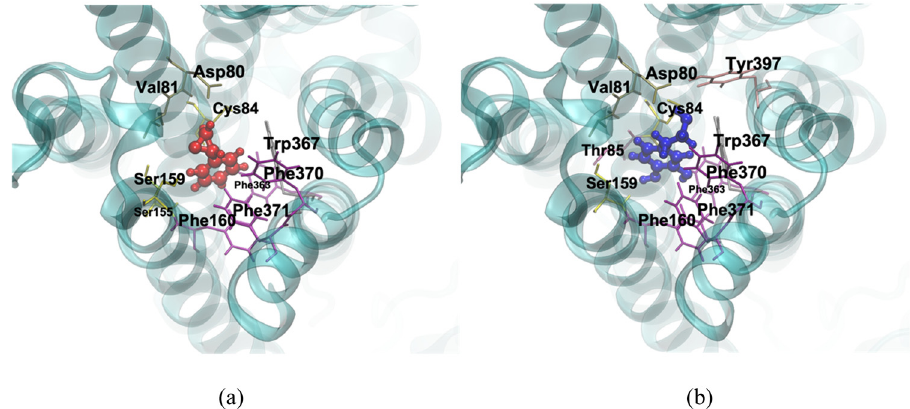
Figure 4: Magni fi cation of the structure of the initial DrD2 binding pocket of styrene oxide ( a ) and dopamine ( b ) . The DrD2 amino acids in contact with the ligands are explicitly drawn and are listed in the leftmost column of Table 1.